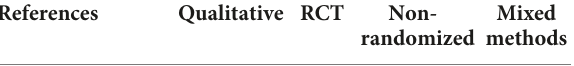
TABLE 4 Mixed methods appraisal tool quality appraisal scores by study design